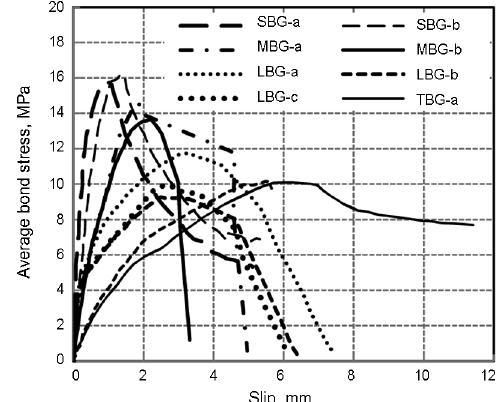
Fig. 9. Average bond stress-slip curves in specimens with GFRP bars bonded with epoxy B